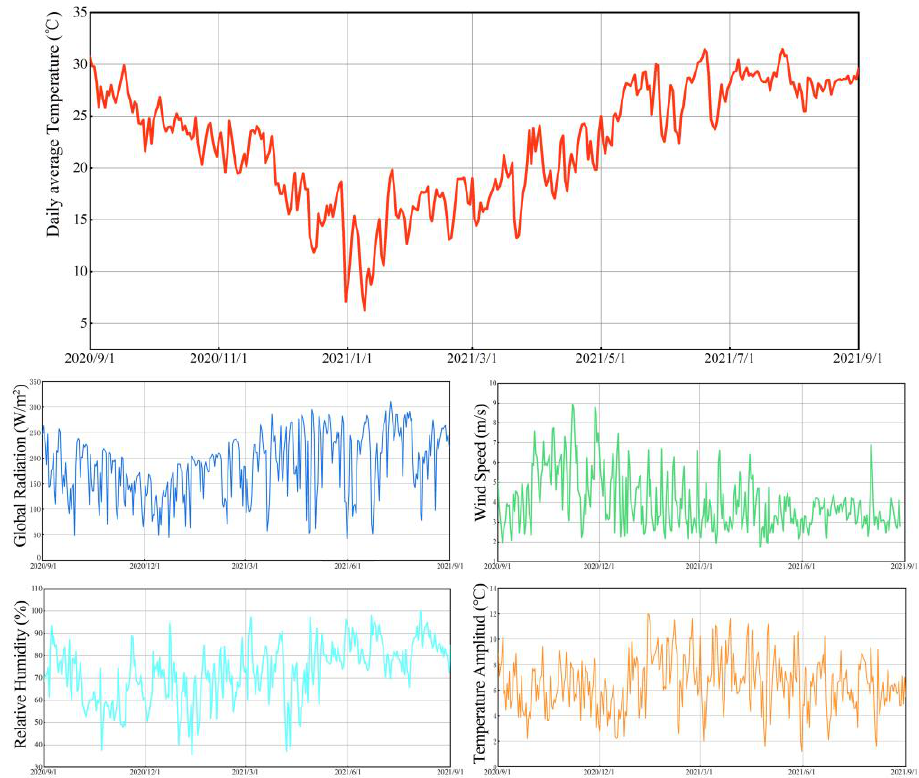
Figure 3. Daily Average values of 5 meteorological